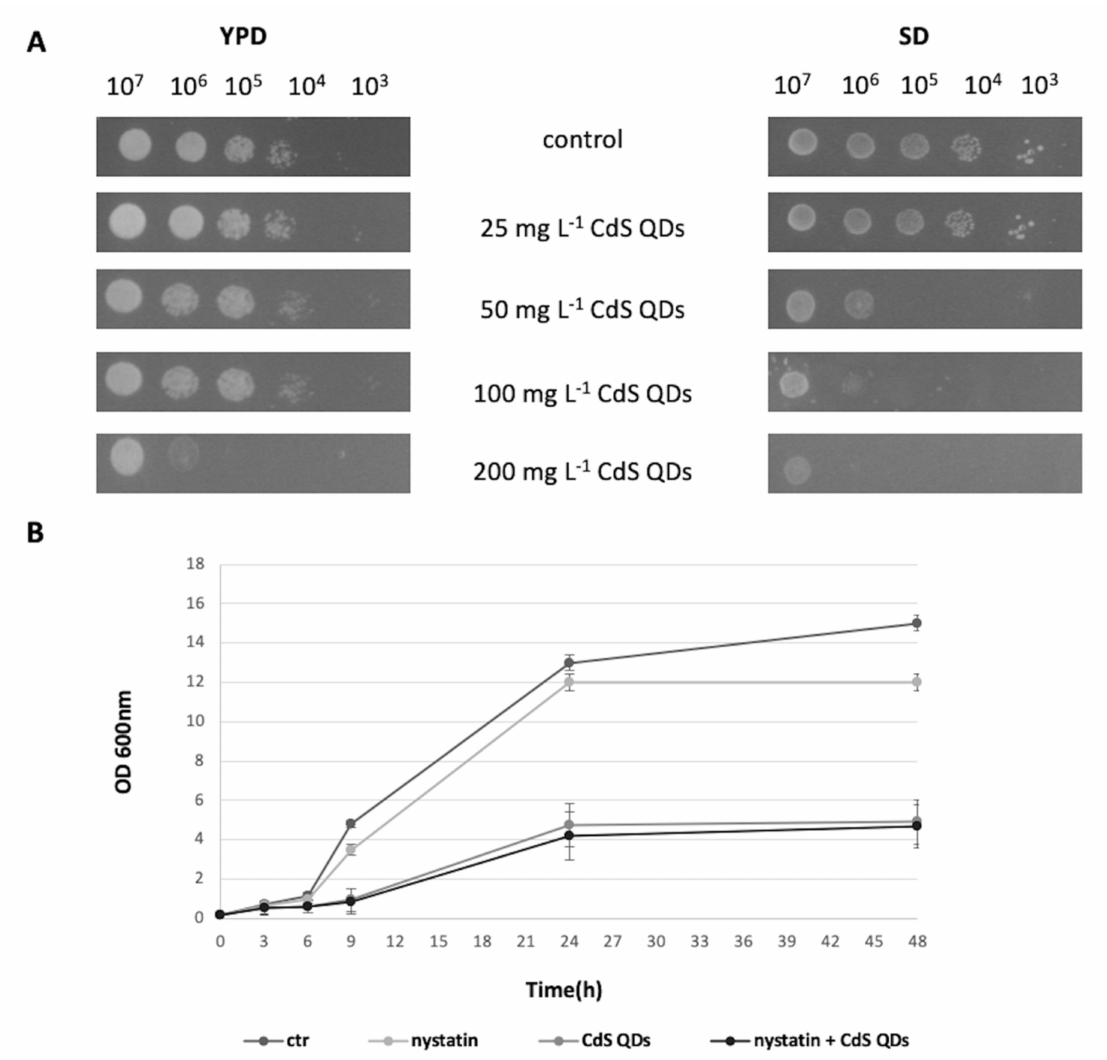
Figure 1. Spot assay and growth curve of S. cerevisiae cells. BY4742 grown on di ff erent media: YPD and SD. ( A ) growth at di ff erent cell dilutions as a ff ected by the treatment conditions: control, 25, 50, 100, 200 mg L − 1 . Cell concentrations, used for the di ff erent tests, are indicated in the first row of the panel. ( B ) Growth curve of BY4742 with and without nystatin at 100 mgL − 1 CdS QDs for 48 h. 3.2. E ff ect of CdS QDs on ROS Generation and Cell Integrity in S.